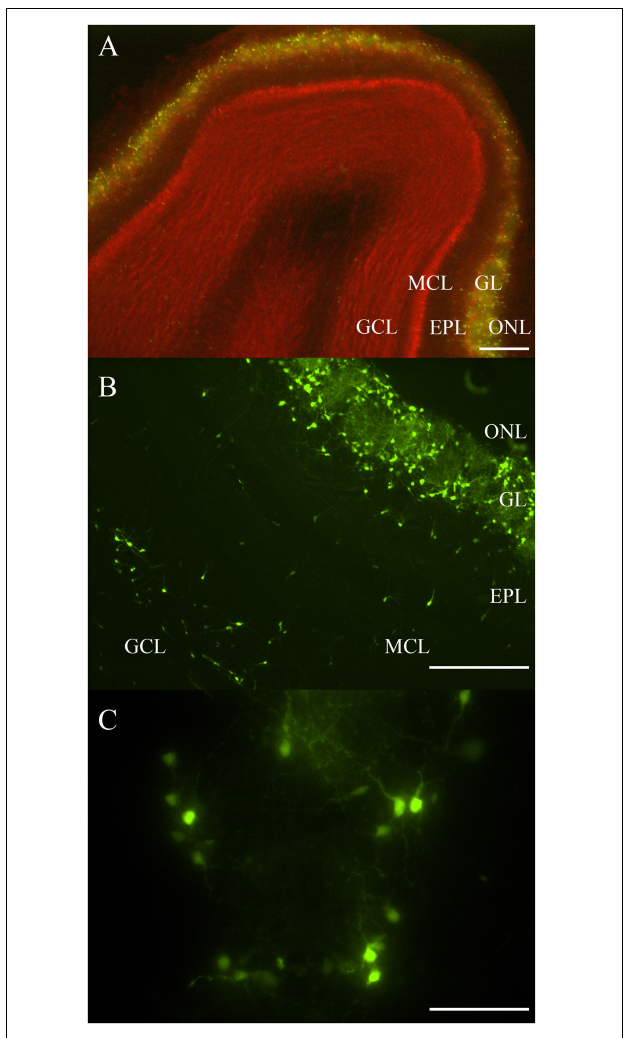
FIGURE 1 | Rat OB and its endogenous DA neurons. (A) A horizontal OB slice with green fluorescent TH-GFP neurons localized to the GL. Discreet layers – EPL, MCL, and GCL – deep to the GL were also emphasized with propidium iodide (red). Scale bar represents 200 µ m. (B) A higher magnification of another OB slice with fluorescent DA neurons localized mostly to the GL, but also some neurons in the EPL, MCL, and GCL. Scale bar represents 100 µ m. (C) A single spherical glomerulus with fluorescent DA neurons around its circumference. Scale bar represents 50 µ m.